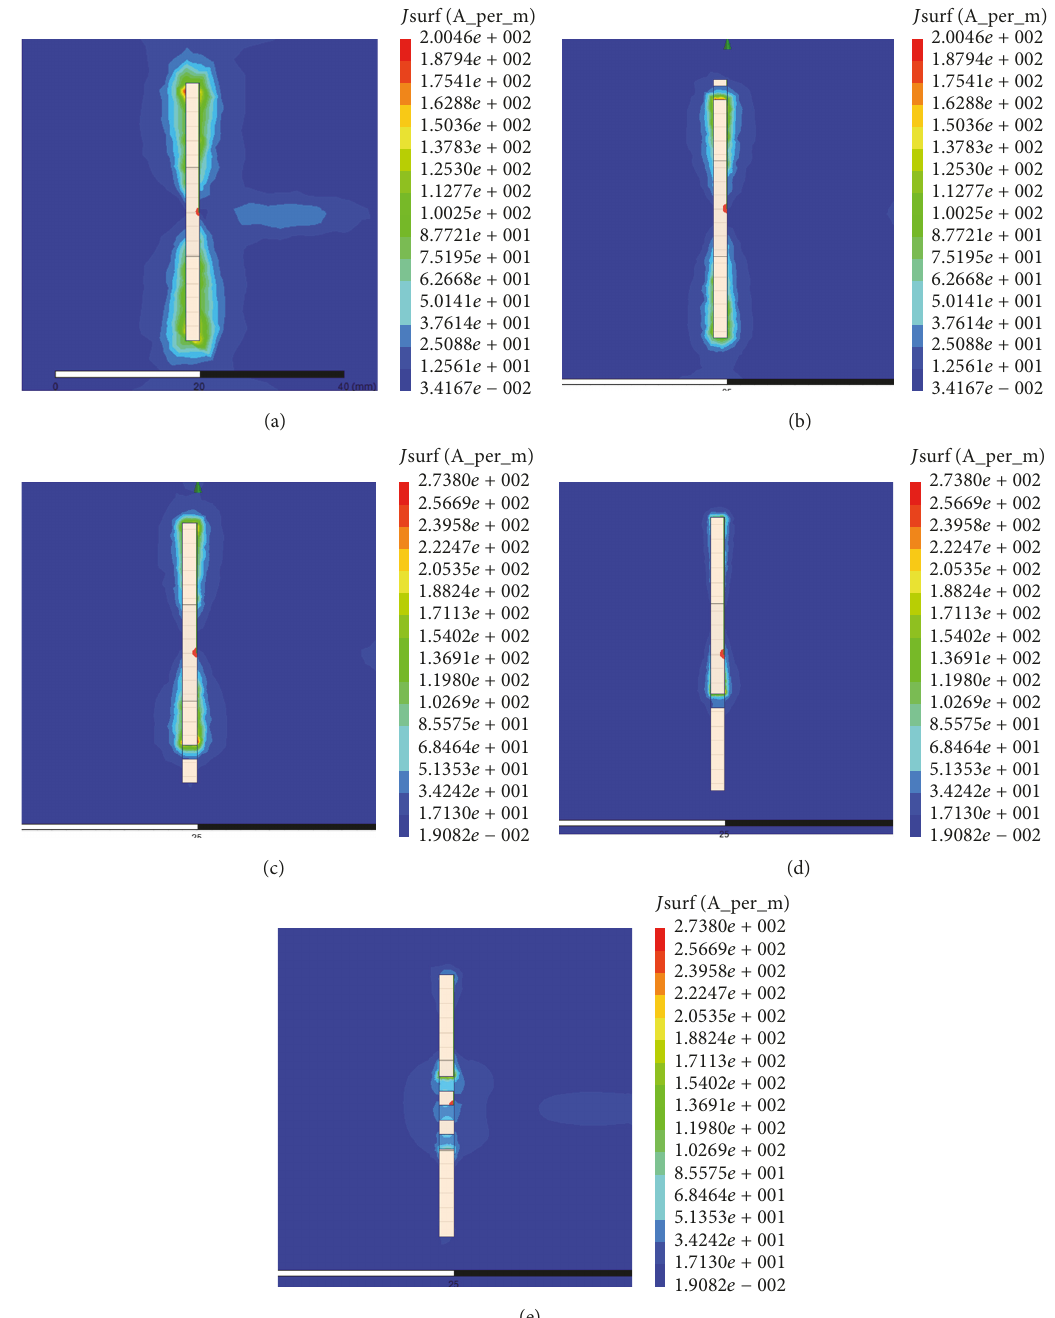
Figure 12: Surface current distribution on the ground plane for five configurations. (a) Config-I, (b) Config-II, (c) Config-III, (d) Config-IV, and (e)